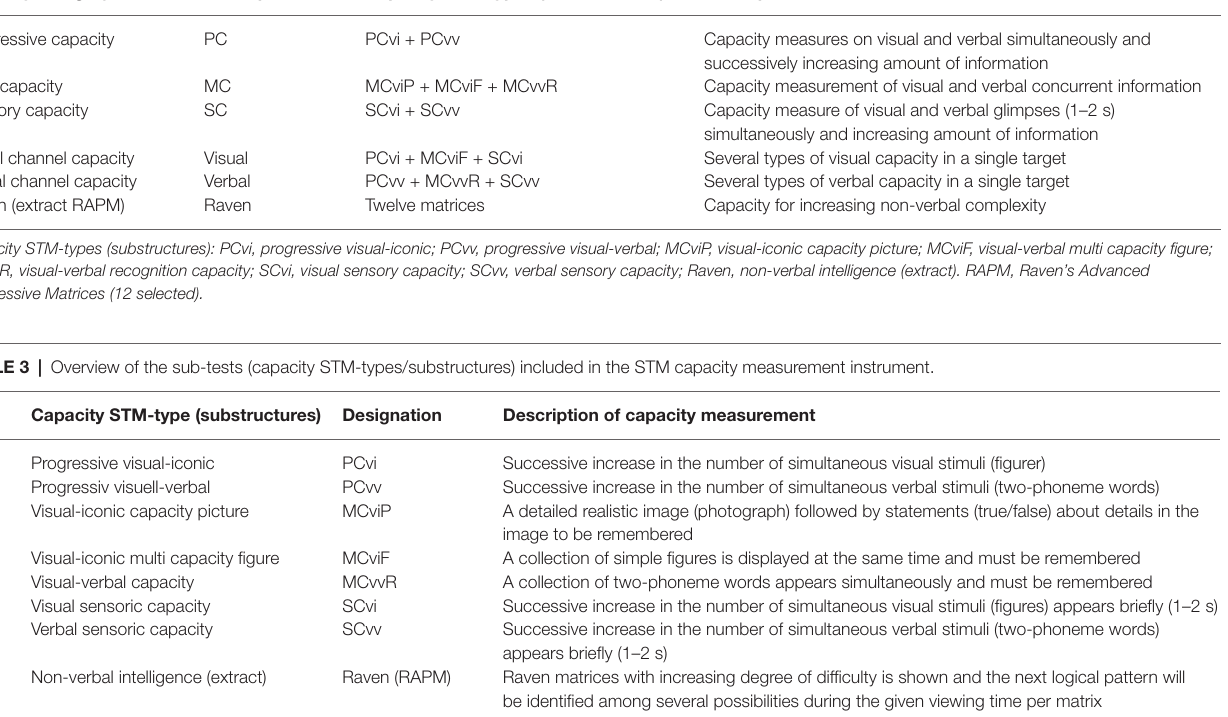
TABLE 2 | Overview of STM capacity categories and various STM-types (substructures) with associated test sets and concepts. Capacity category